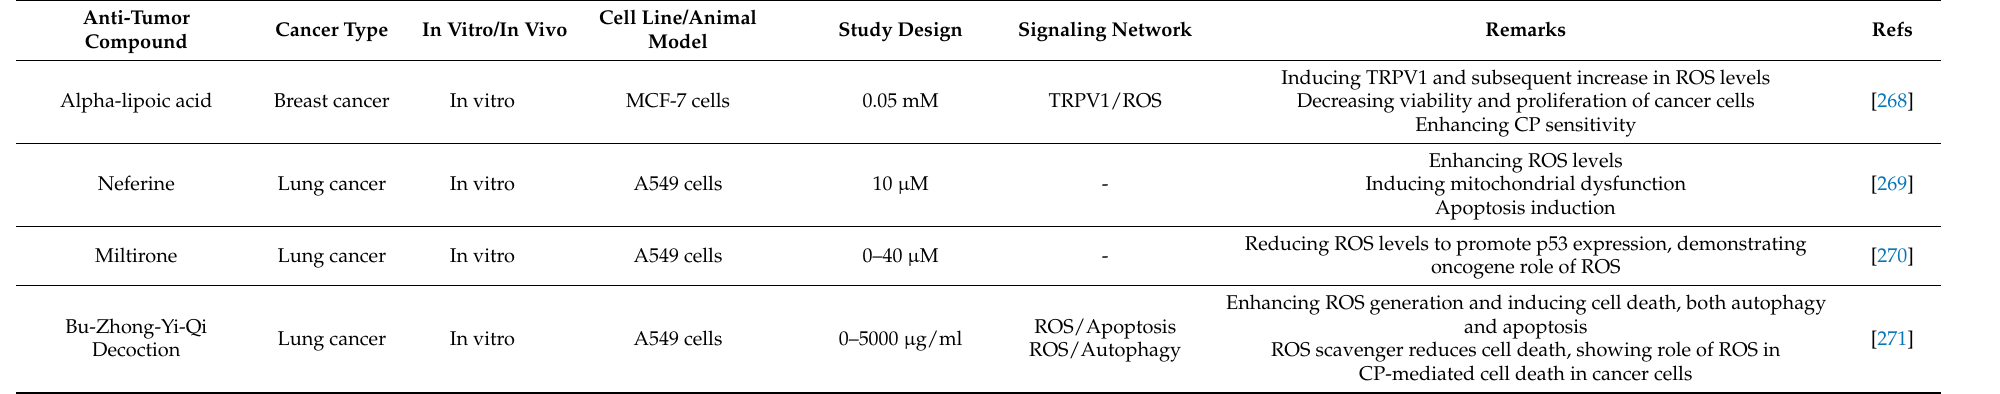
Table 4. Plant derived-natural compounds regulating ROS levels in CP